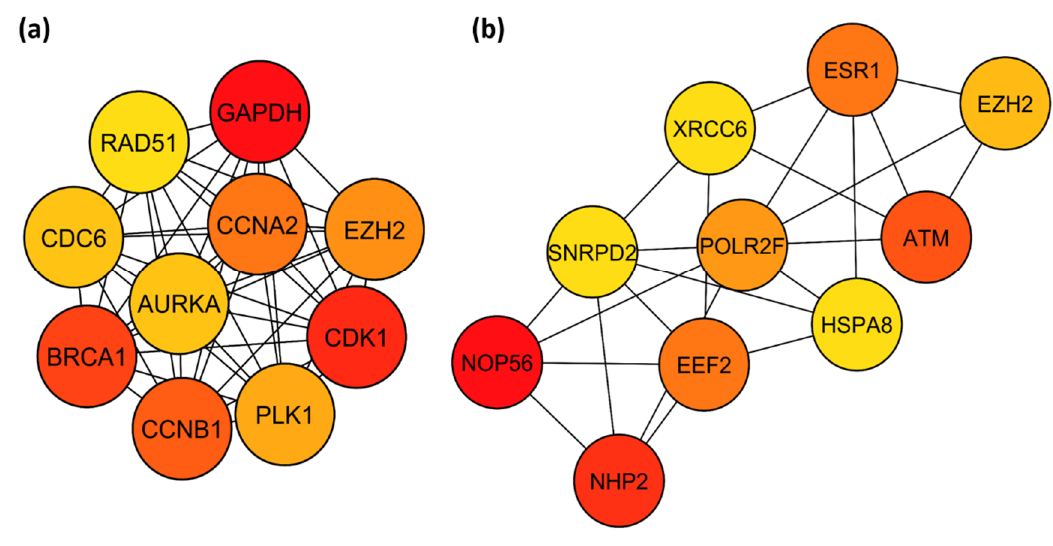
Figure 9. Top 10 hub genes of the PPI network constructed from ( a ) EC-specific DEGs and ( b ) stage I-IV DEGs, ranked according to degree. The hub genes were identified using Cytohubba. The colour of the node represents degree, with red representing a higher degree and yellow a lower degree.